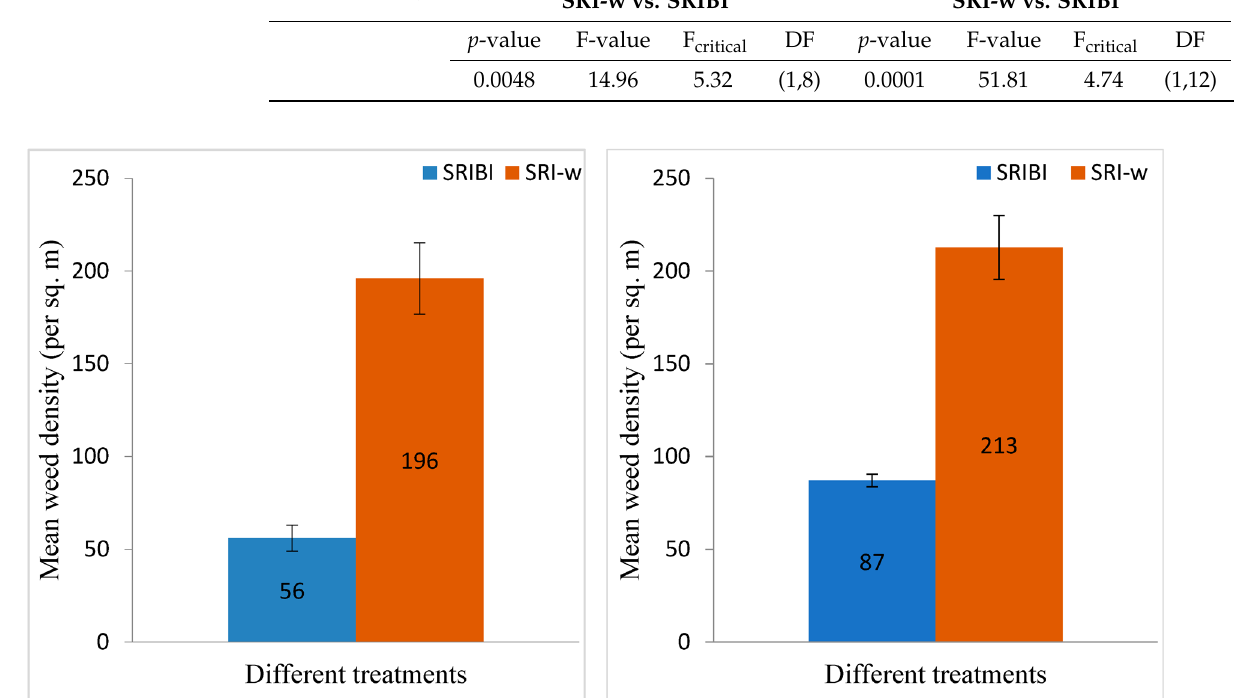
Figure 1. Weed density in the two SRI-based treatments (SRI-w: SRI weedy control; SRIBI: SRI with beans intercropping) ( Left : 2019; Right : 2020). Table 2. Parameters from ANOVA statistical analysis for weed density comparison.